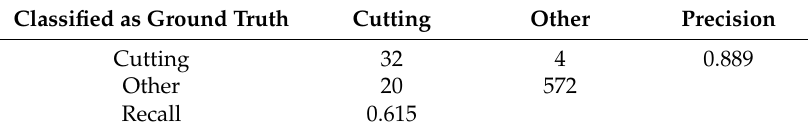
Table 11. Values for the optimal F ( F = 0.77, recall = 0.692, precision = 0.867).